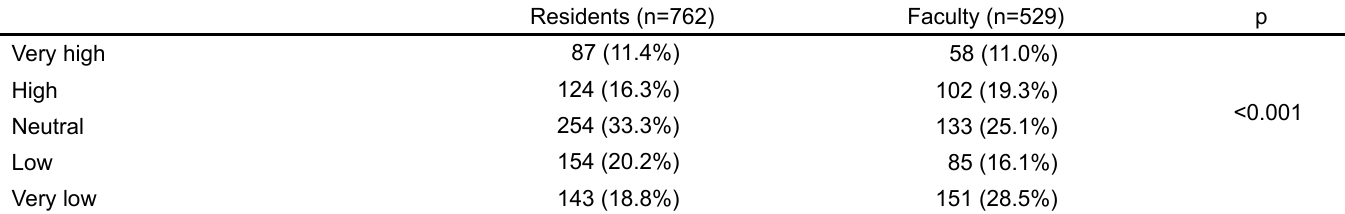
Table 5. Level of interest in using social media in residency